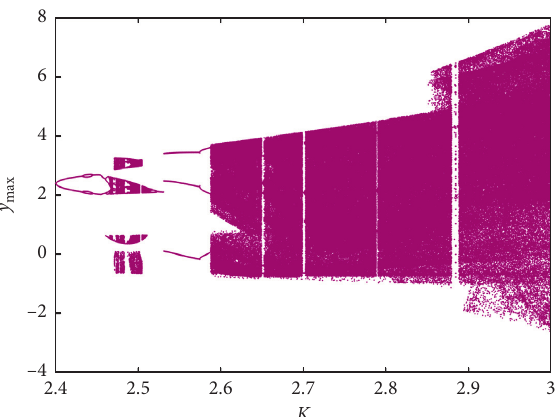
Figure 4: Bifurcation of the FOPLL system for q � 0.98 and G � 1 for various values of K .